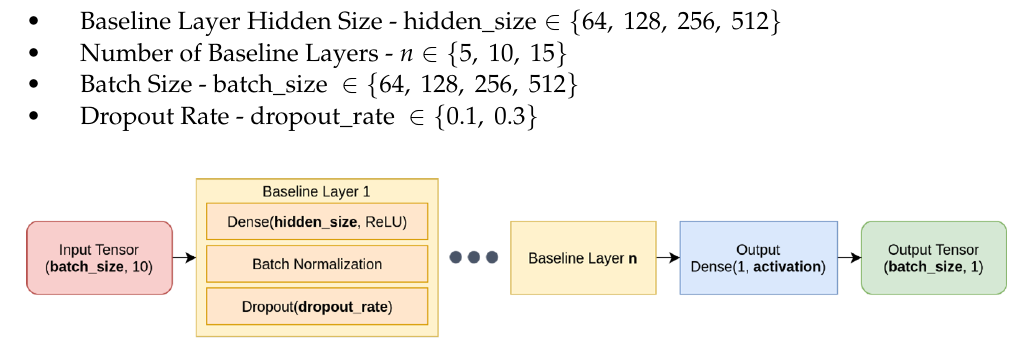
Figure 3. The Baseline architecture was used to infer the hourly sun irradiation for the 48-h forecasting. The hyperparameters tuning was set on the parameters highlighted in